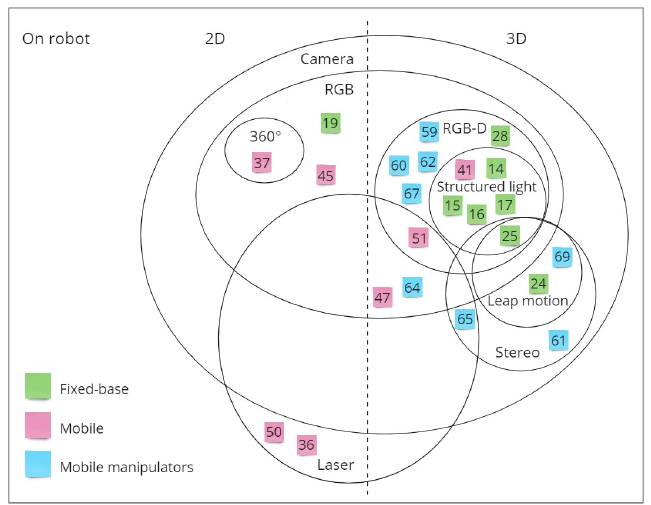
Figure 3. Most relevant sensors for HRP which can be found on the